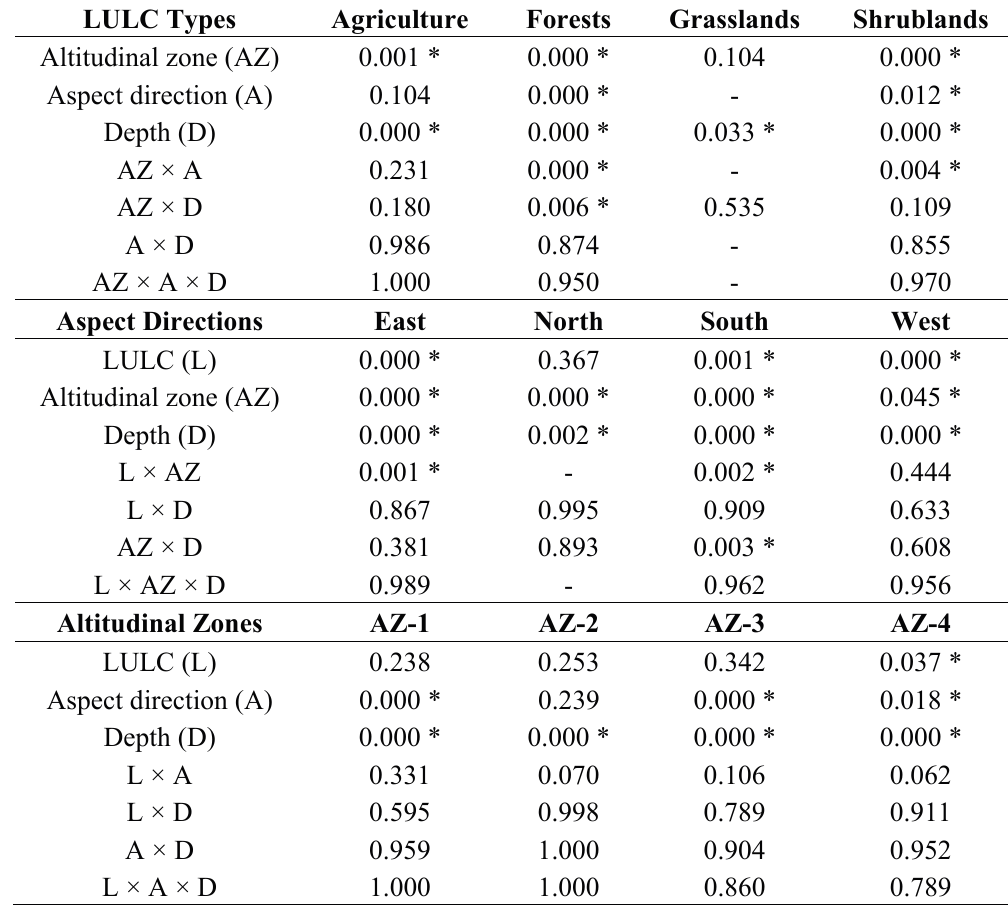
Table 4. Effects of fixed terms (LULC, altitudinal zone, aspect direction and depth) and their associated interactions on SOC density (kg · m − 2 ) under each LULC type, altitudinal zone and aspect